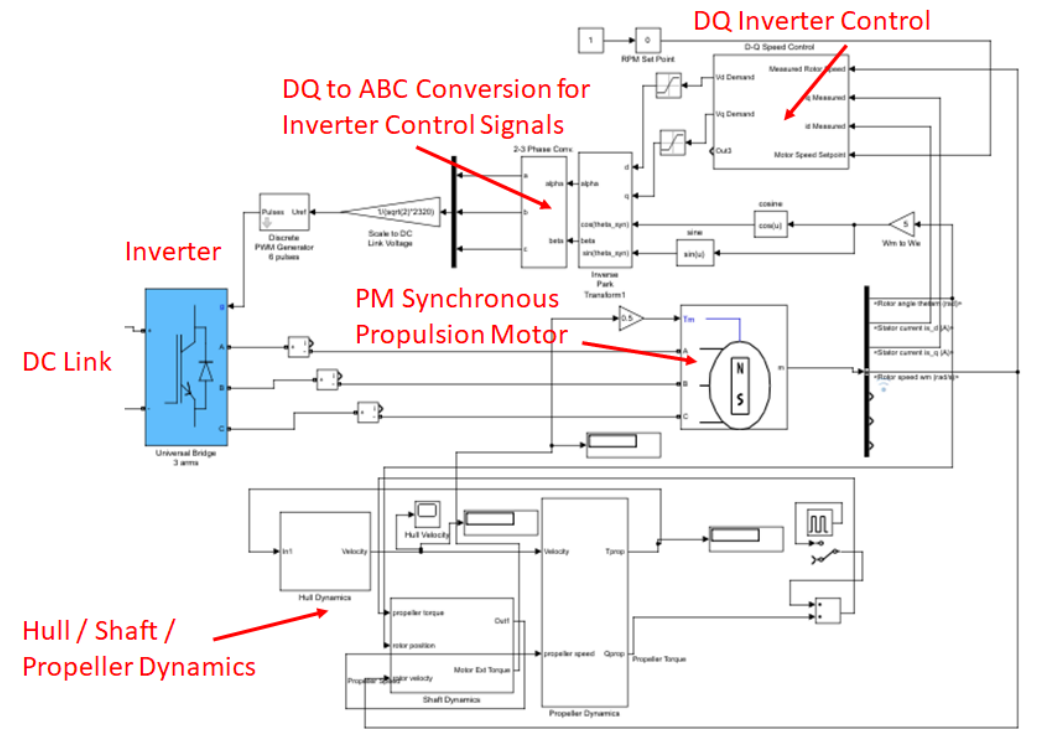
Figure 7. DQ Controller/Inverter/Propulsion Simulink TM Model.